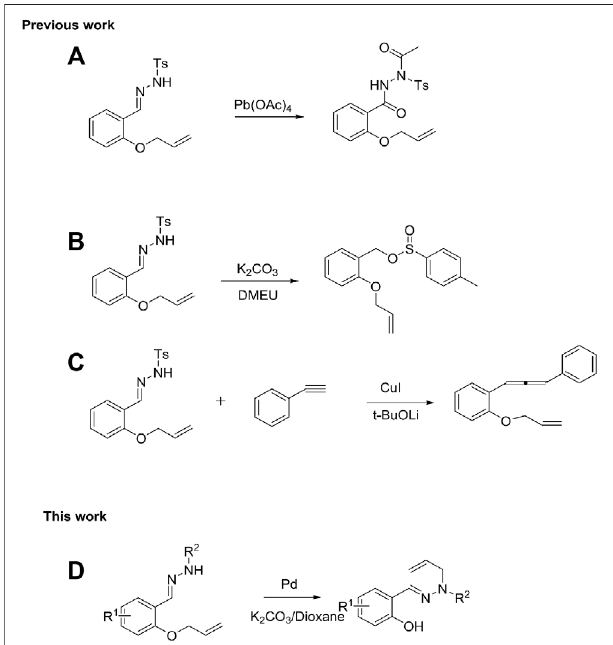
SCHEME 1 | Reaction types with N -tosylhydrazones as substrate.